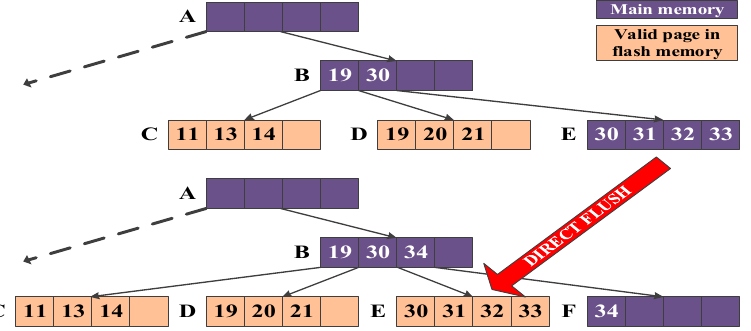
Figure 9. Example of the insert operation in the case of sequential insertions.